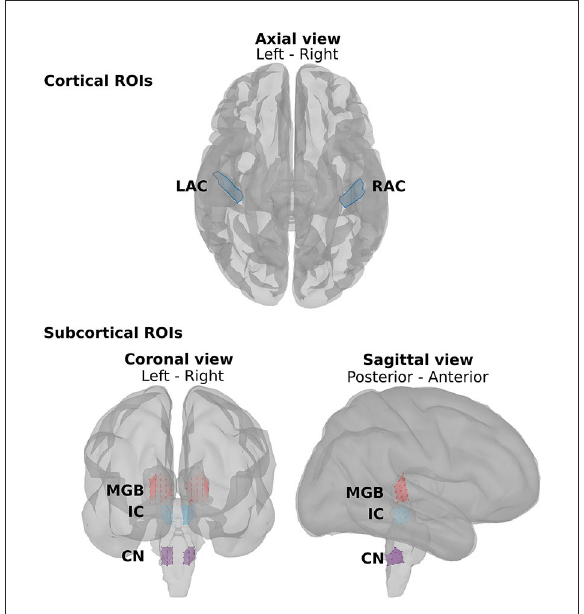
FIGURE2 The regions of interest (ROIs) along the auditory pathway. The cortical ROIs are located bilaterally in the left auditory cortex (LAC) and right auditory cortex (RAC). The subcortical ROIs include the left and right medial geniculate body (LMGB, RMGB), the left and right inferior colliculus (LIC, RIC), and the left and right cochlear nucleus (LCN, RCN).